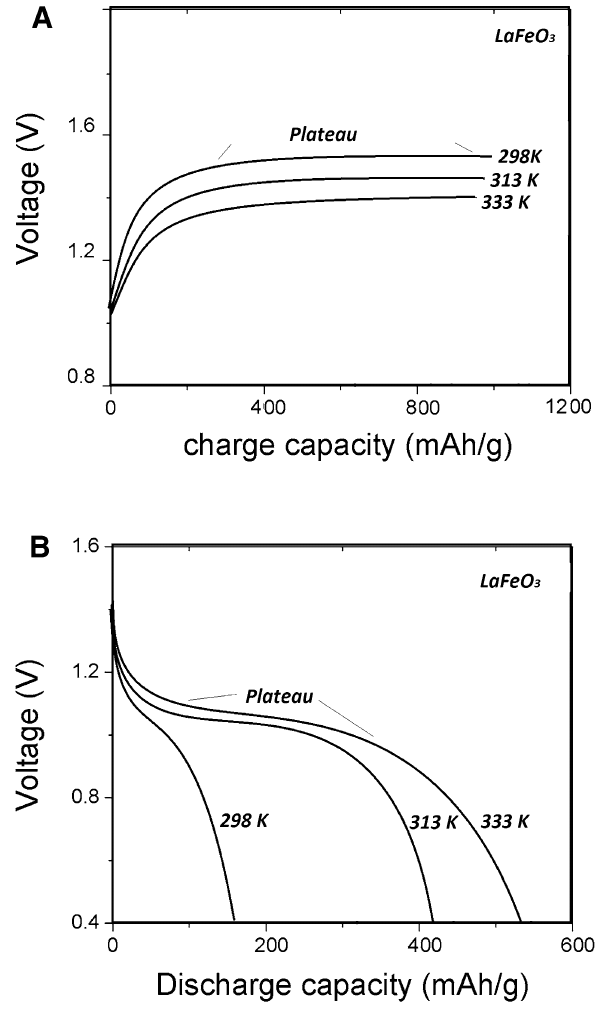
Fig. 5 Maximum discharge capacity as a function of the electrolyte concentration in a RE-perovskite LaCrO 3 at 298 K. Data adapted from